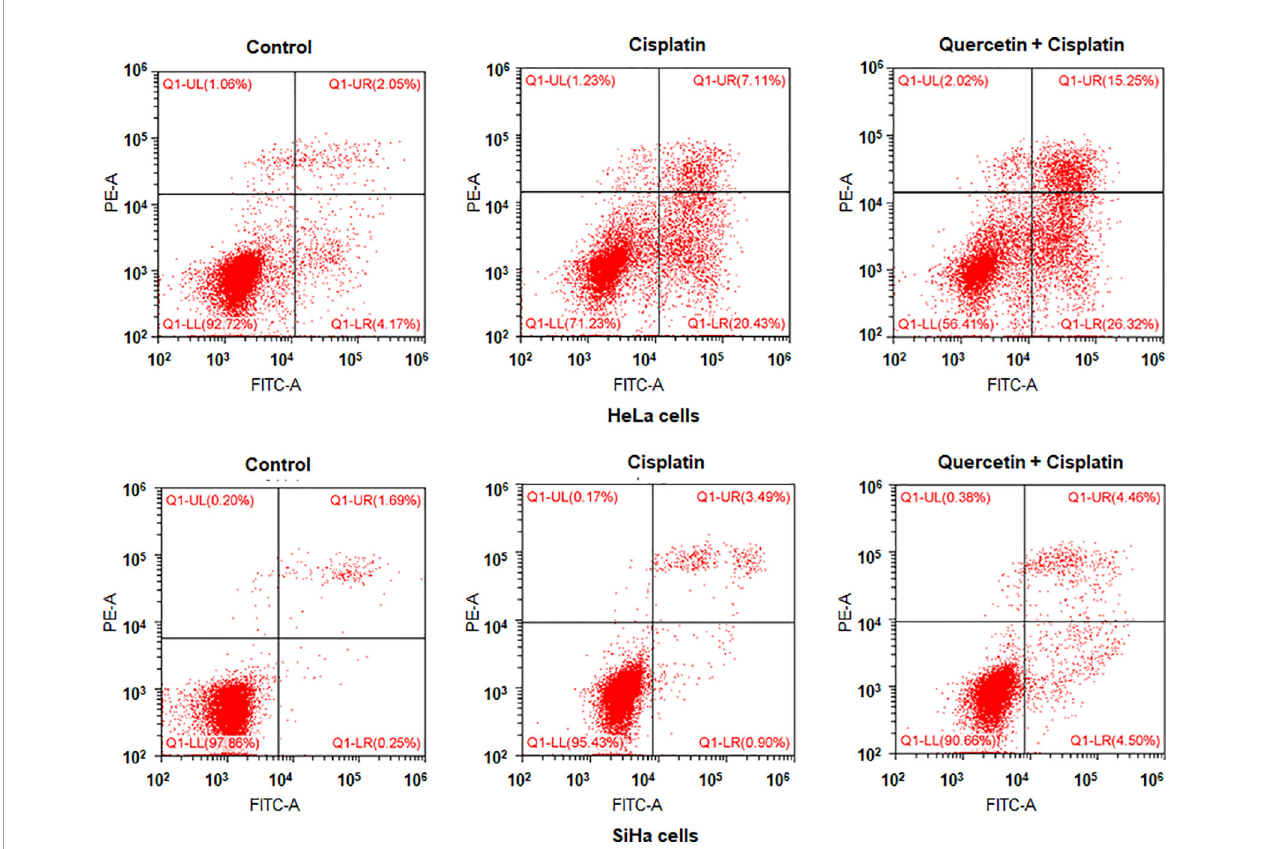
FIGURE 9 | Quercetin enhances cisplatin-induced apoptosis of cervical cancer cells. HeLa cells were treated with 15 m M quercetin and 10 m M cisplatin for 48 h, and SiHa cells were treated with 30 m M quercetin and 12 m M cisplatin for 48 h. Flow cytometry analysis was utilized to measure apoptosis of HeLa and SiHa cells after various